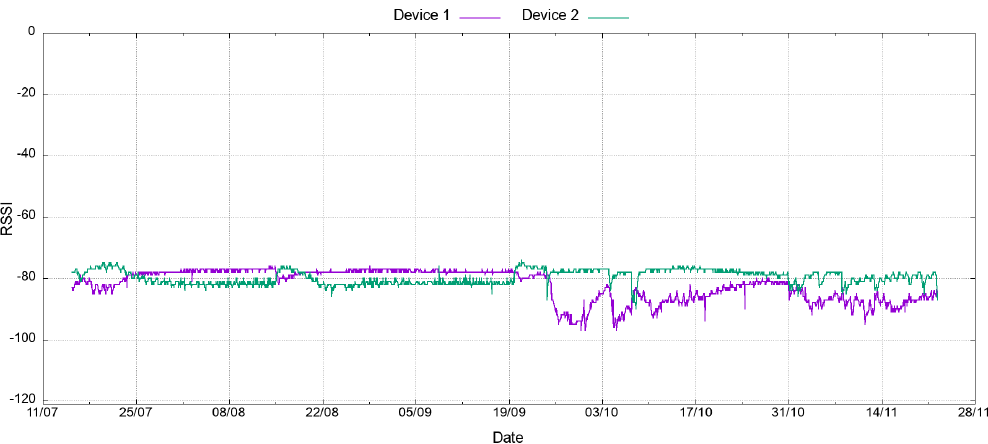
Figure 8. wM-Bus smart meter devices with unstable RSSI 2 (Location 4).